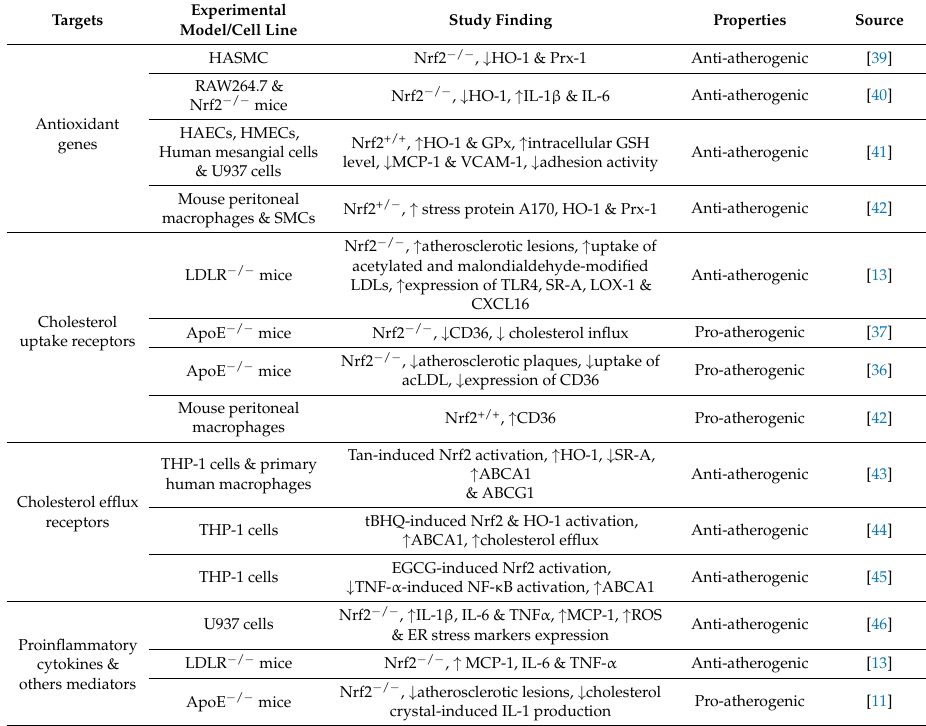
Table 1. The pro and anti-atherogenic role of Nrf2 in regulating target genes involved in macrophage foam cells